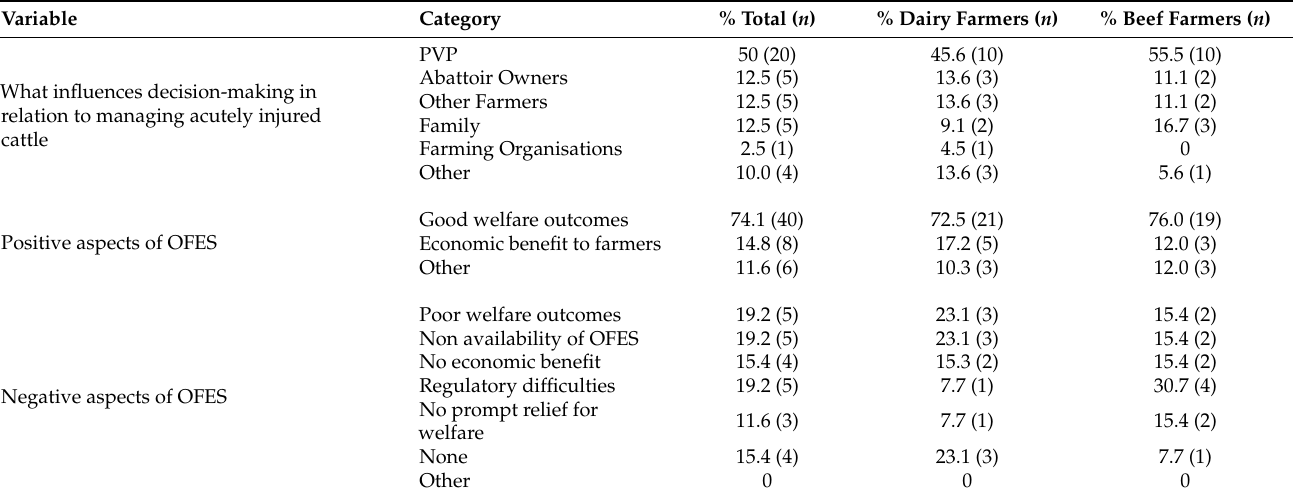
Table 3. Characteristics of Dairy and Beef Farmers Regarding the Management of Acutely Injured Cattle and On-Farm Emergency Slaughter (OFES): Willingness/Influences